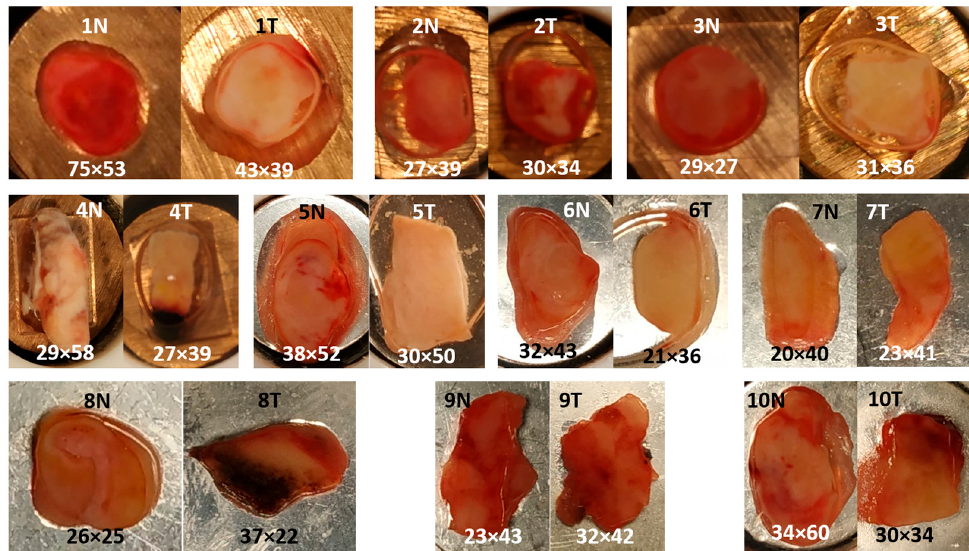
Figure 2. Photomicrographs of control (N) and tumor (T) from 10 resected human bladder. Speci- mens 1–4 were placed on copper disks, specimens 5–10 on silver disks. Grid size of each Raman map at 250 µm step size is